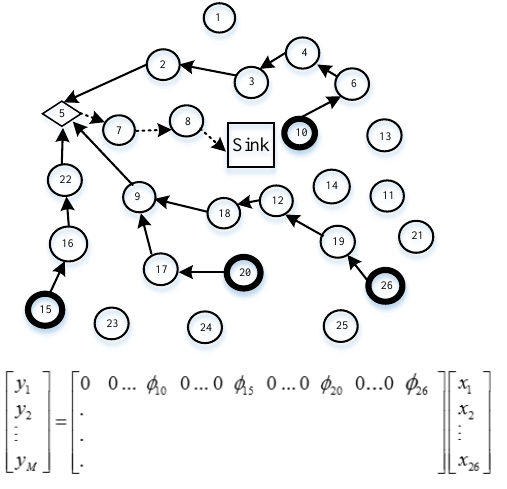
Figure 9. An example of data gathering per random projection node using Φ